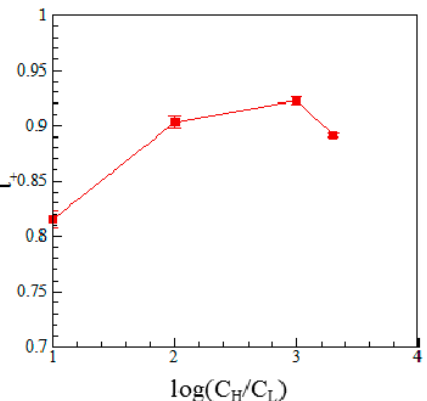
Figure 6. Variation of transference number with the concentration ratio given a microchannel length of 1 mm.